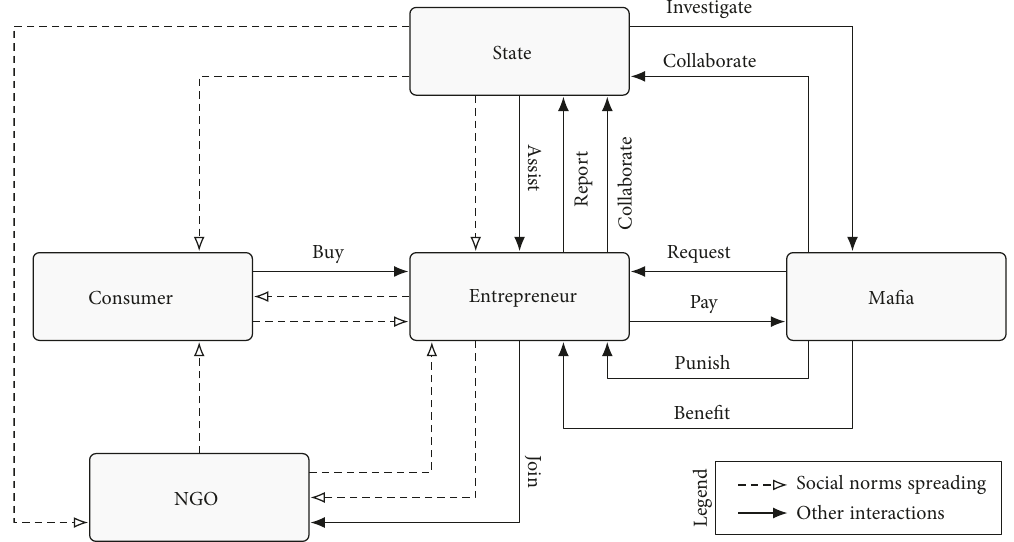
Figure 1: Schematic of the agents in the Palermo Scenario and their dynamics. Boxes represent agent types and arrows represent